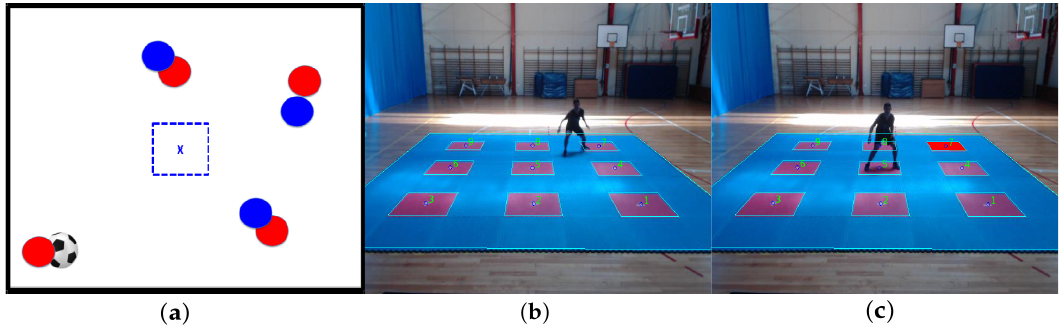
Figure 11. No target situation and no target situation detected in platform central position. ( a ) Visual tactical soccer situation. ( b ) No reaching target situation. ( c ) No reached target situation detected (back in